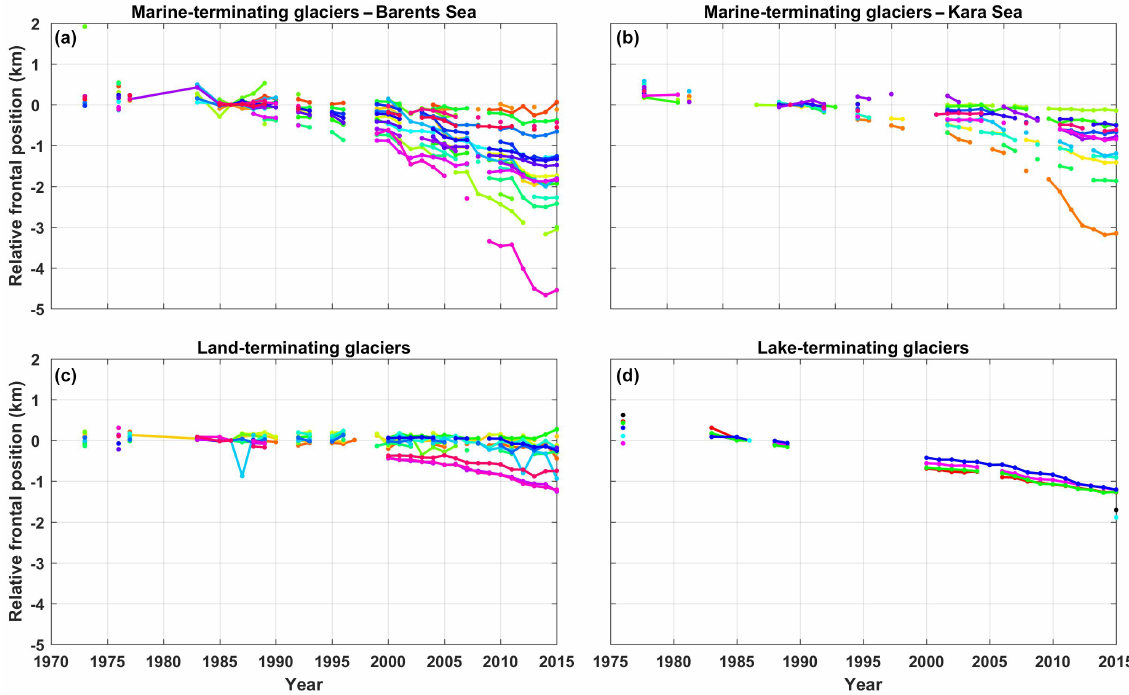
Figure 5. Relative glacier frontal position over time, from 1973 to 2015, for (a) marine-terminating outlet glaciers on the Barents Sea coast; (b) marine-terminating outlet glaciers on the Kara Sea coast; (c) land-terminating outlet glaciers; and (d) land-terminating outlet glaciers. Within each plot, frontal positions for each glacier are distinguished by different